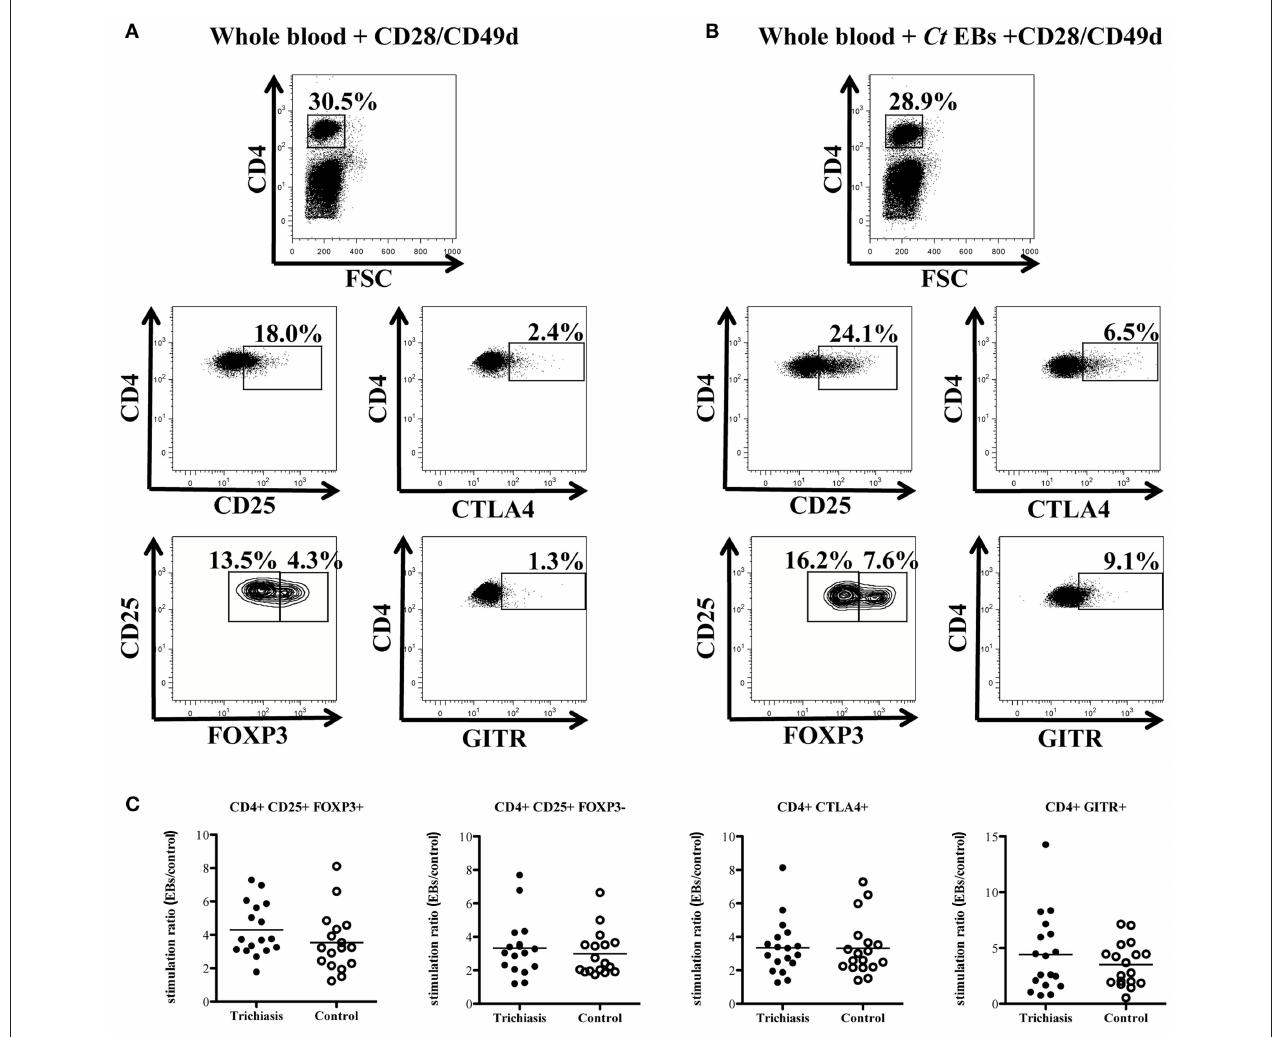
FiGure 3 | representative FaCS plots of whole blood cultured for 48 h with co-stimulatory molecules Cd28/Cd49d (a) or CD28/CD49d and chlamydial elementary bodies (B) are shown to demonstrate the gating strategy used to enumerate the percentage of Tregs. FOXP3 + cells were gated within the population of CD4 + CD25 + cells. The CD25 + population was taken as continuous (CD25 hi and CD25 lo expressing cells were not differentiated). CD4 + effector cells were identified as the